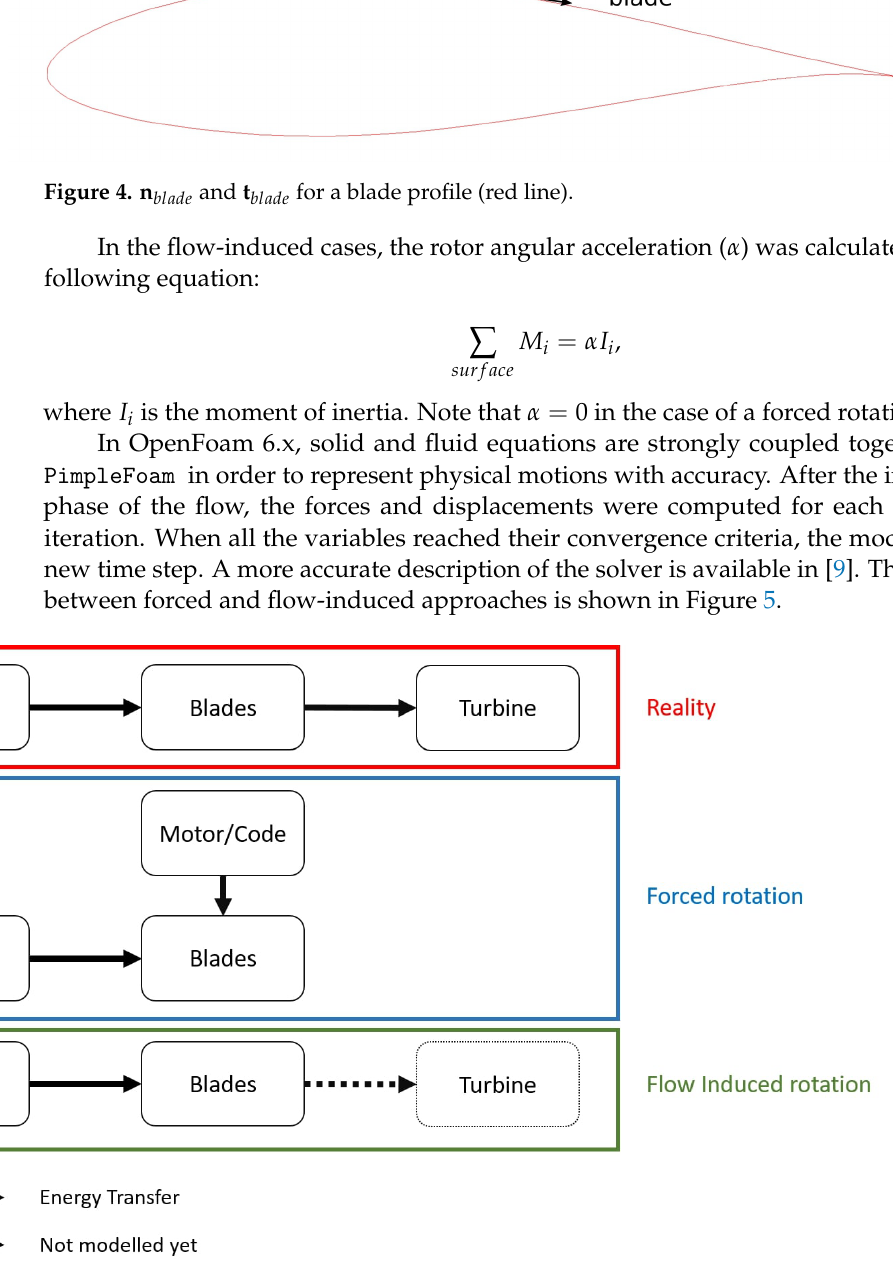
Figure 5. Energy recovery chain for real life (red box), the forced rotation (blue box) and the flow induced rotation (green box). Black arrows represent the energy